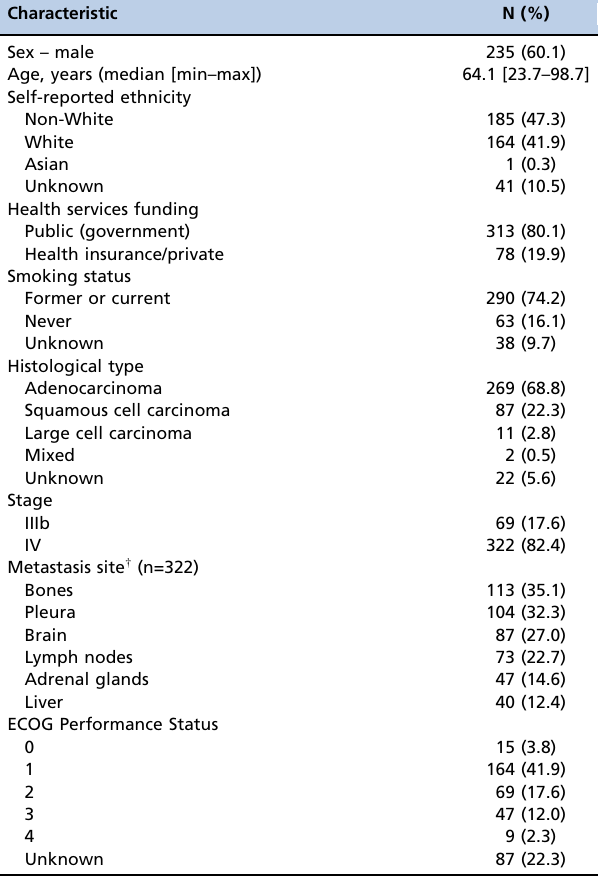
Table 1 - Baseline Demographic and Clinical Characteristics (n=391).